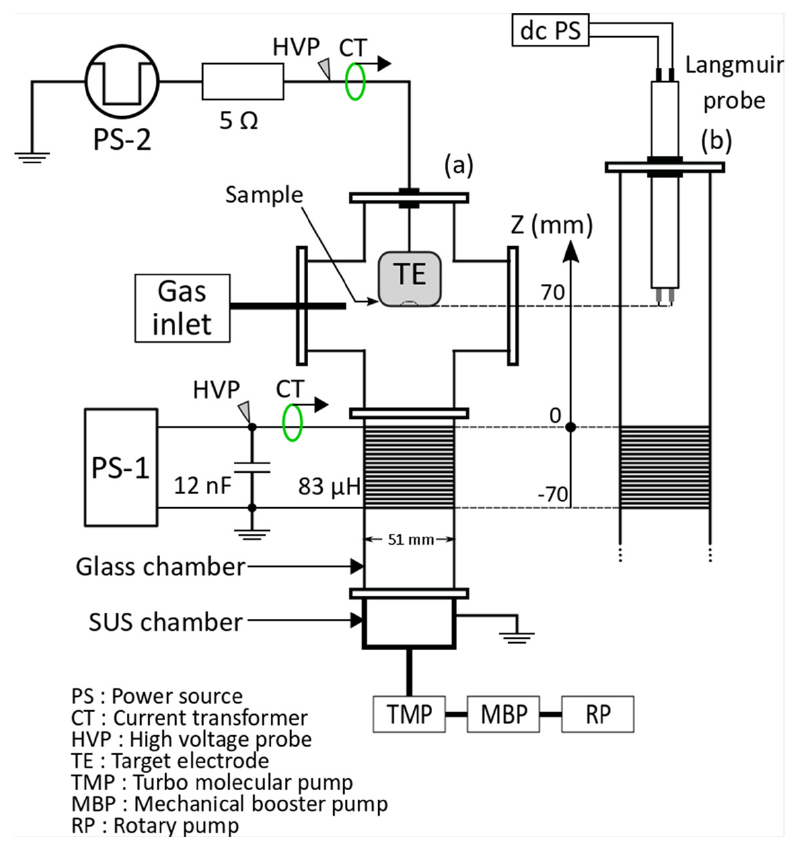
Figure 1. Schematic of the experimental apparatus.